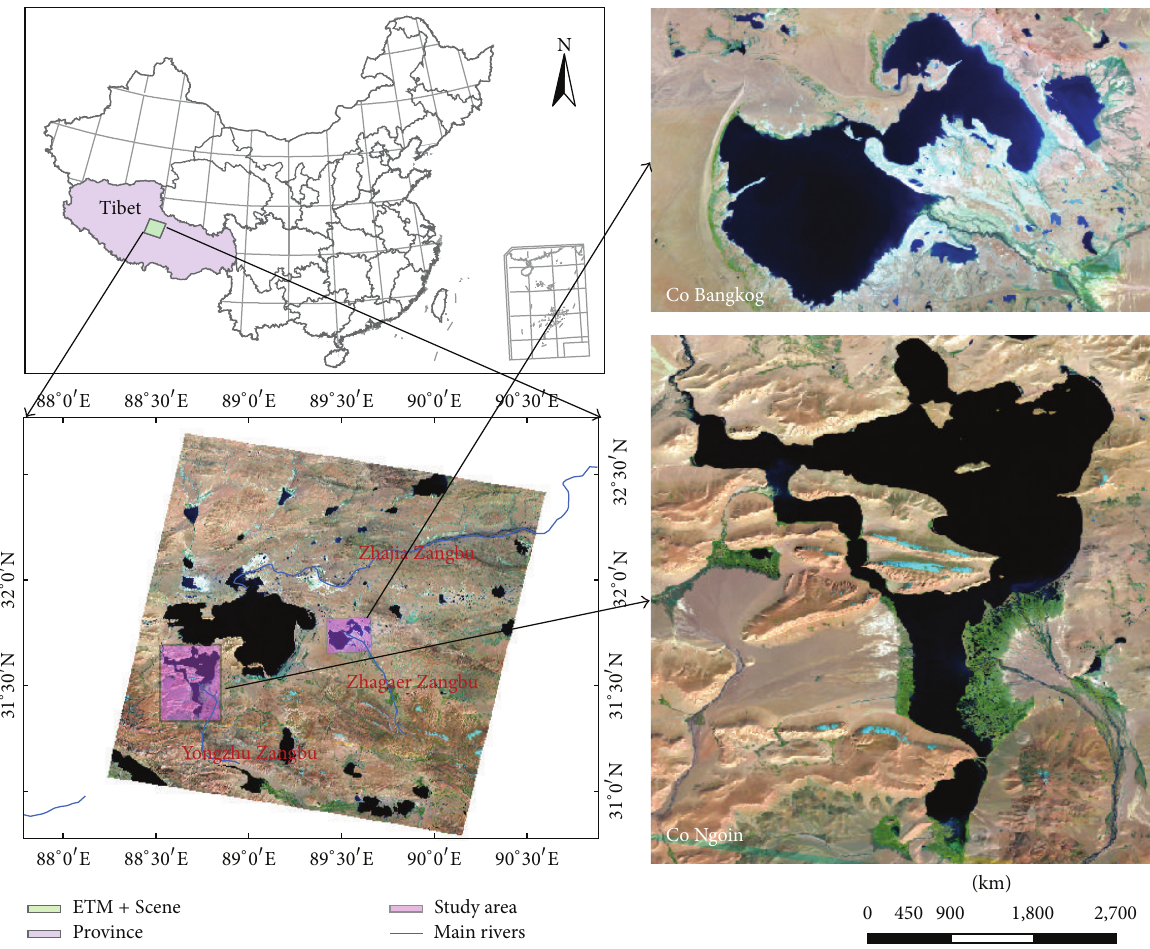
Figure 1: Locations of Co Ngoin and Co Bangkog (RGB543 TM image).